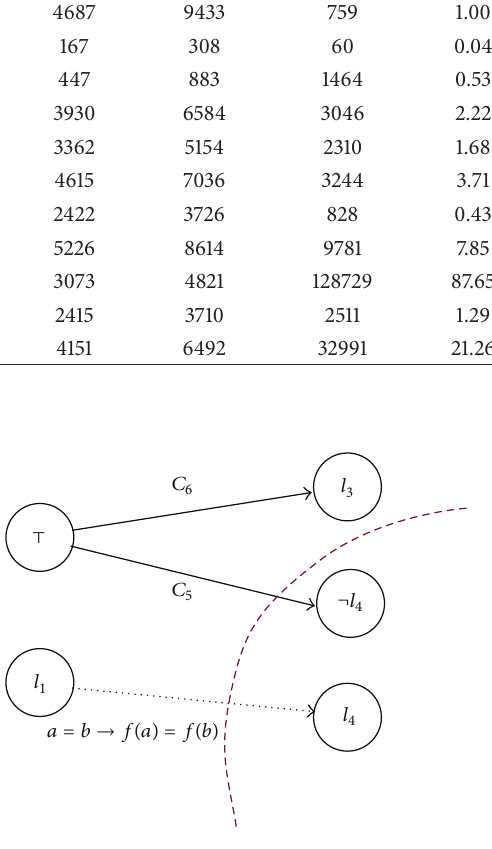
Figure 4: The implication graph in step 4.